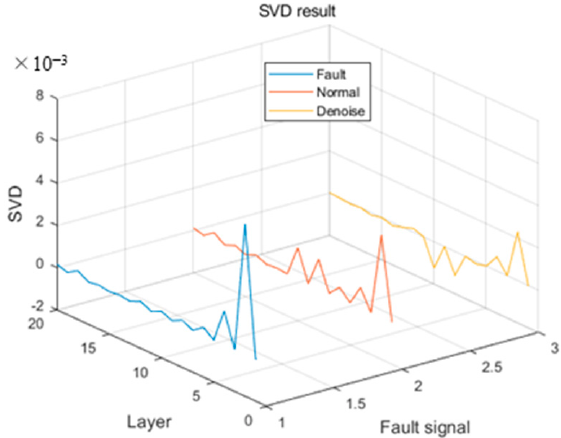
Figure 10. SVD valve after denoising. Table 2. Results of our time-domain detection method obtained under different fault conditions.